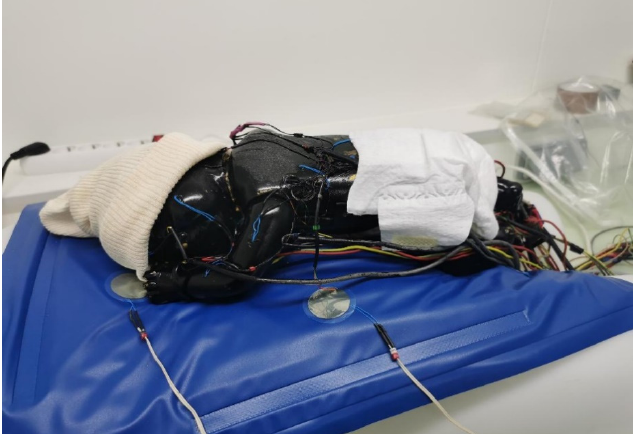
Figure 1. The 1500 g anthropomorphic mannequin wearing a head cap and a diaper. The mannequin is an anatomically faithful model of a small-for-gestational-age neonate. The anatomic shapes are important because they modify the heat exchange coefficients and, thus, condition heat exchanges with the environment.